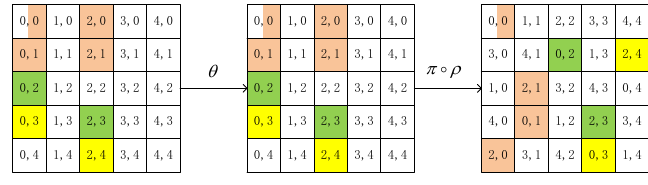
Figure 12: Attack on 6-round Ketje Sr